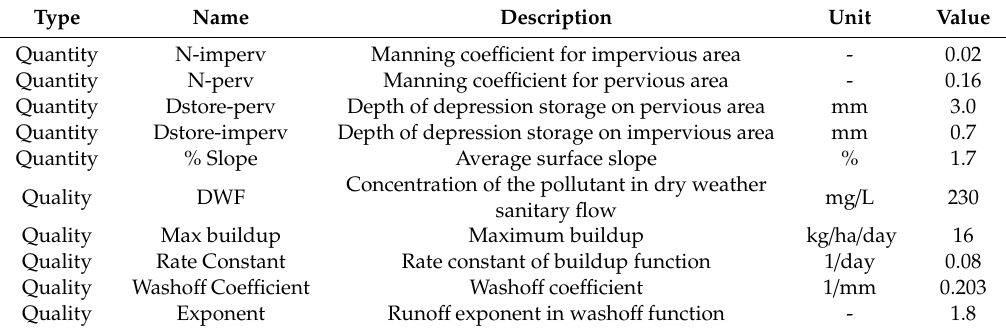
Table 1. Main parameters obtained from model calibration in SWMM 5.1.014.